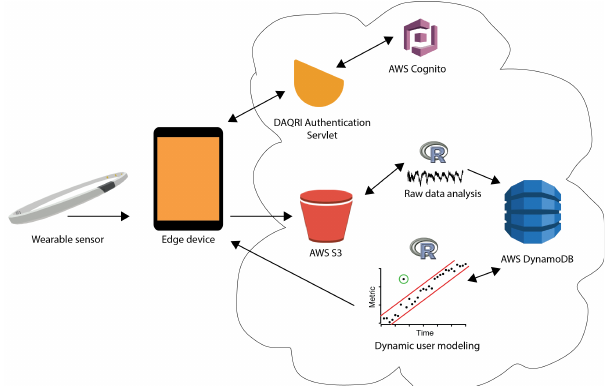
Figure 1. System architecture consisted of a wearable EEG headband (Left), an application running on an edge device (Middle), and a cloud platform built using AWS services and custom code (Right). Main cloud applications were: Authentication with Cognito (top) and storage in S3 and DynamoDB and analysis with R (bottom). Details are provided in the